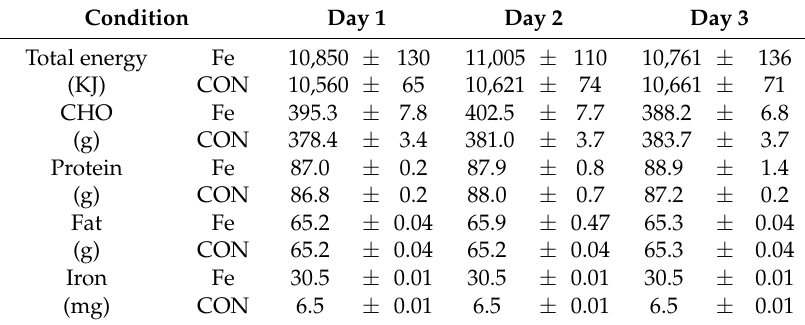
Table 4. Total energy and macronutrient intakes during training